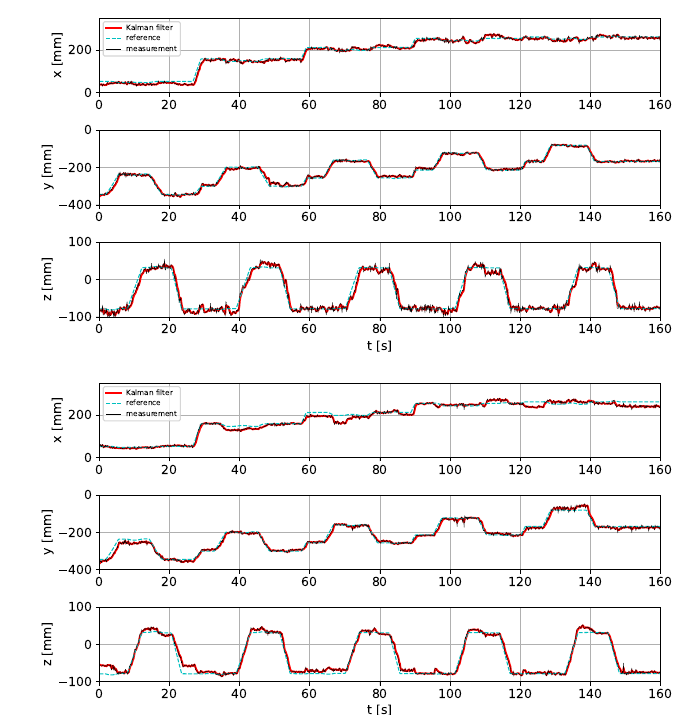
Figure 13. Comparison of the robot position prediction accuracy for graph fitting and sparse CNN on the training data set, learned on the image from the right camera. The shaded area indicates that the robotic arm is in front of the camera.